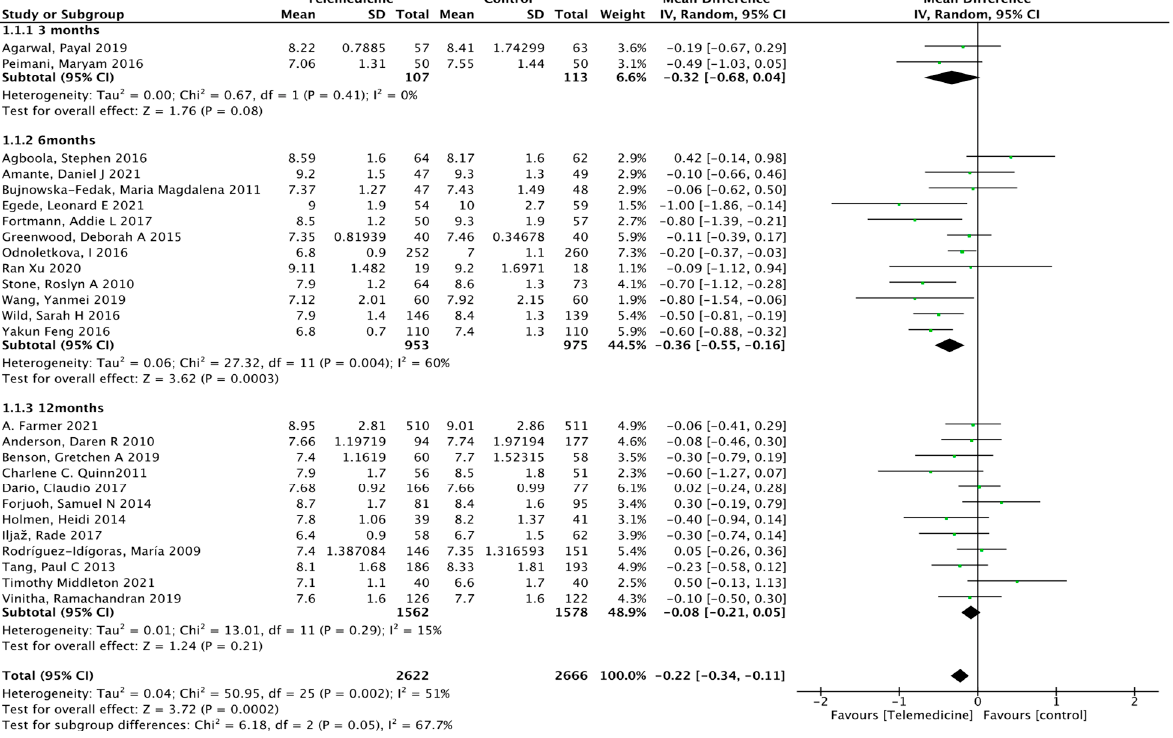
Figure 4. Subgroup analysis showed higher HbA1c reduction at 6 months of intervention.